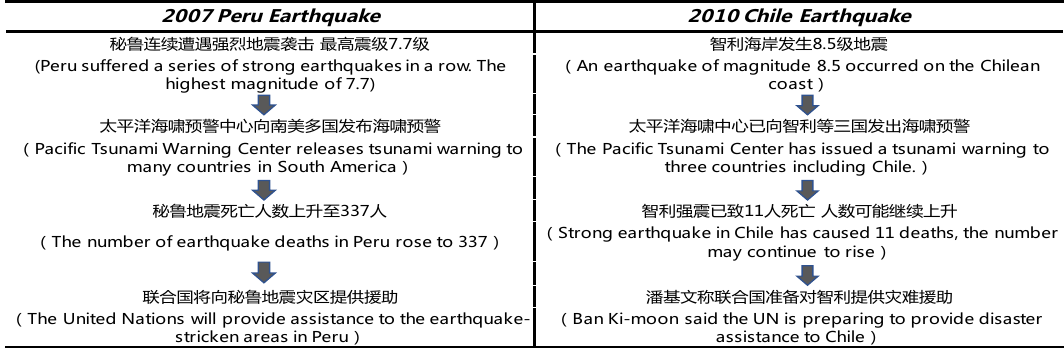
Figure 1. News reports on the “2007 Peru Earthquake” and the “2010 Chile